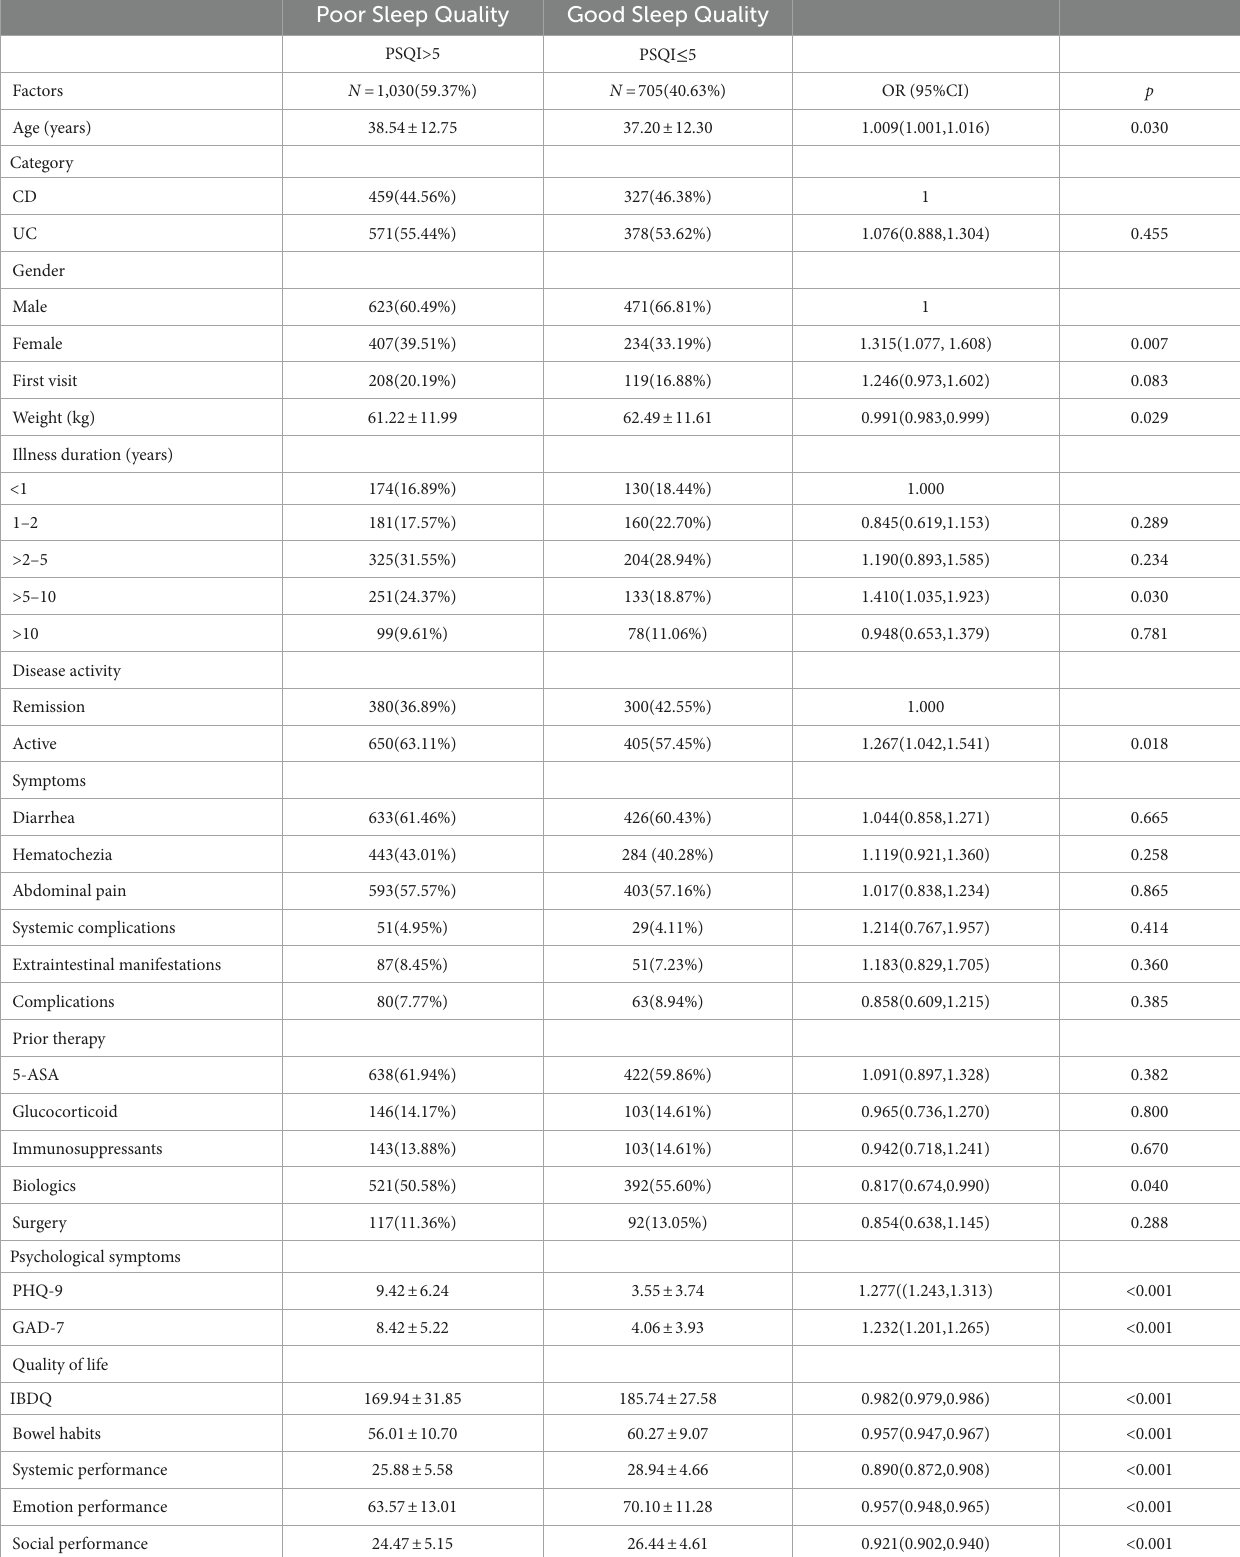
TABLE 4 Univariate analysis of variables for poor sleep quality in the training